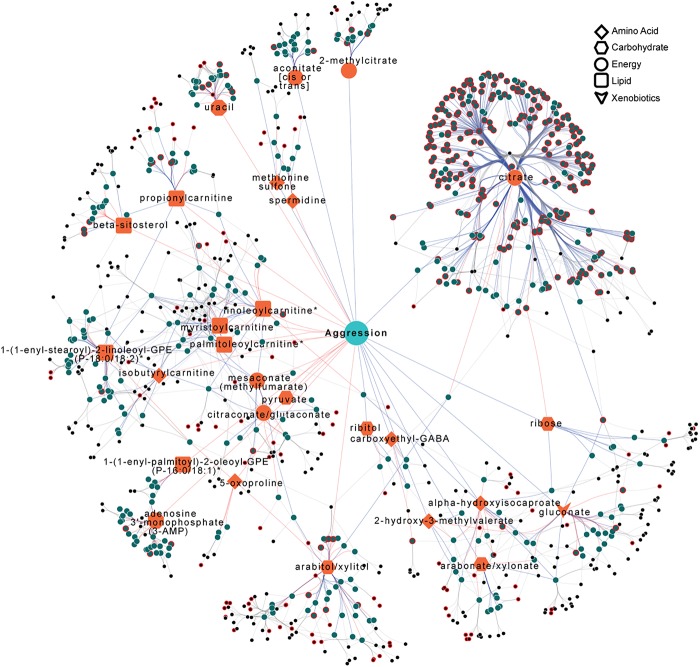
Integrated network that incorporates polymorphic markers, variation in candidate gene expression, and variation in metabolite abundances associated with variation in male aggression. Orange nodes indicate metabolites correlated with aggression and teal nodes indicate candidate genes correlated with these metabolites. Black nodes indicate mQTLs associated with candidate genes. Nodes with red borders indicate a direct association with the organismal phenotype. The different shapes of the orange nodes indicate different metabolic super pathways. Red edges indicate positive correlations, while blue edges represent negative correlations. Black edges connect polymorphic markers with their associated genes. The polymorphic markers, candidate genes, and metabolites presented in the figure are listed in Supplemental Table S12.